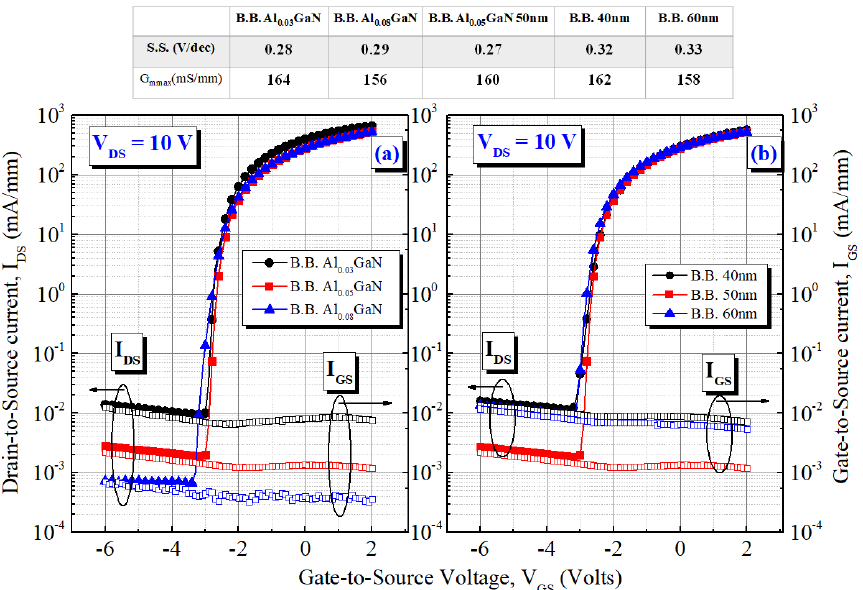
Figure 3. The measured I DS –V GS at V DS = 10V of devices. ( a ) the different Al mole fraction; ( b ) the different thickness of B.B. devices.